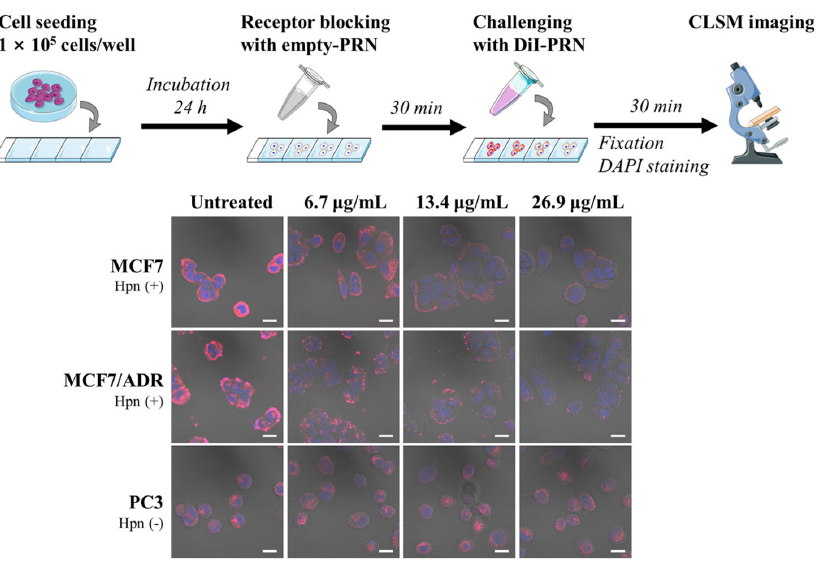
Figure 6. Cellular uptake of 1,1 ′‐ dioctadecyl ‐ 3,3,3 ′ ,3 ′‐ tetramethylindocarbocyanine perchlorate (DiI) ‐ loaded PEGylated (5 mol%) and RIPL peptide ‐ conjugated nanostructured lipid carrier (PRN; DiI ‐ PRN) after hepsin (Hpn) pre ‐ blocking in Hpn ‐ positive cells (MCF7 and MCF7/ADR) and Hpn ‐ negative cells (PC3) by CLSM. Cells were pretreated with empty ‐ PRN (lipid concentration of 0, 6.7, 13.4, and 26.9 μ g/mL) for 30 min to ensure receptor blocking, followed by treatment with DiI ‐ PRN (DiI ‐ equivalent concentration of 25 ng/mL) at 37 °C for 30 min. The nucleus was stained with 4 ′ ,6 ‐ diamidino ‐ 2 ‐ phenylindole (DAPI) for blue fluorescence and merged with the red fluorescence of cytoplasmic DiI. Scale bar = 10 μ m.